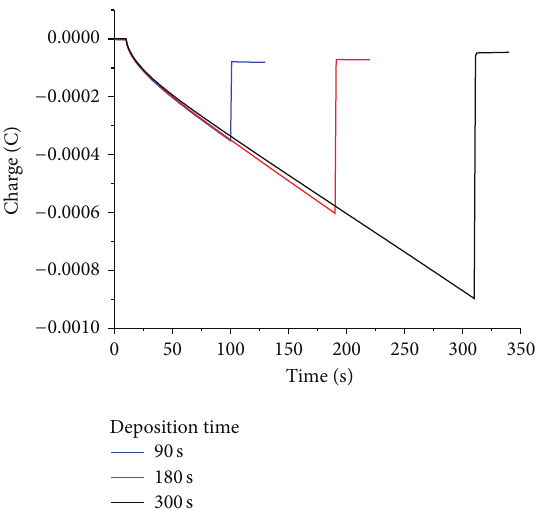
Figure 9: Chronocoulometry plot of thallium deposition with varying time and removal on glassy carbon electrode in the presence of 1 mM TlSO 4 in deaerated 0.5 M Na 2 SO 4 solution.